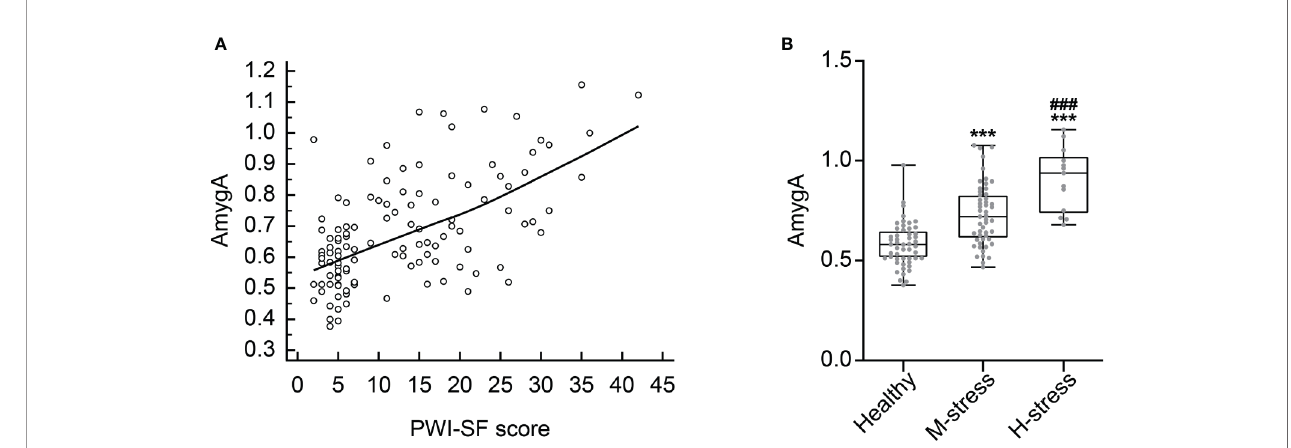
FIGURE 4 | (A) Correlation scatter plot between AmygA and PWI-SF score. (B) Comparison of AmygA according to the severity of psychological stress. Healthy, n = 51; M-stress, n = 51; H-stress, n = 13. PWI-SF; psychosocial well-being index-short form, Healthy, healthy group; M-stress, moderate stress risk group; H-stress, high